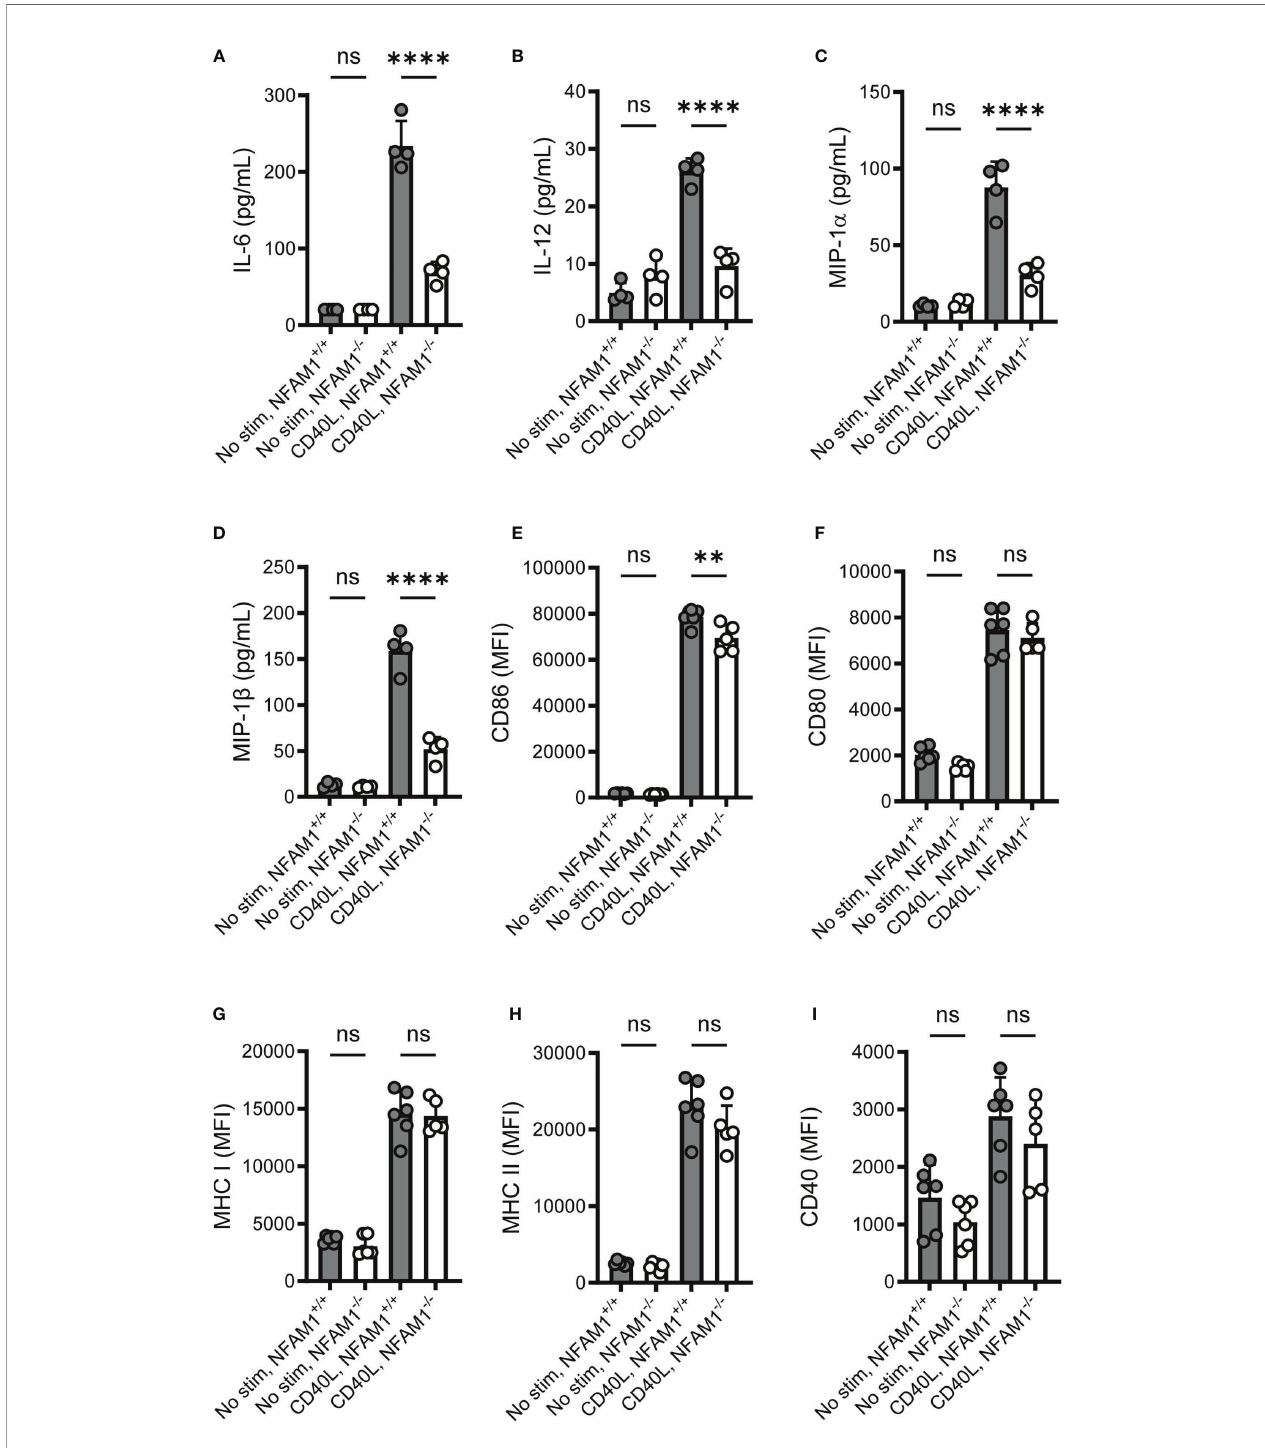
FIGURE 5 | Upon stimulation with CD40L, NFAM1 -/- monocytes exhibit reduced production of multiple pro-in fl ammatory cytokines and chemokines but have little to no defect in upregulation of cell surface activation markers. (A – D) Monocytes from 4 NFAM1 +/+ and 4 NFAM1 -/- mice were primed with IFN- g and stimulated with CD40L for 48 hours. Mean levels of IL-6, IL-12, MIP-1 a and MIP-1 b is shown in (A – D) , respectively. (E – I) . Monocytes from 6 NFAM1 +/+ and 6 NFAM1 -/- mice were primed with IFN- g and stimulated with CD40L for 24 hours. Mean expression of CD86, CD80, MHC-I, MHC-II and CD40 is shown in (E – I) respectively. Cytokine and chemokine data are representative of three independent experiments. Cell surface expression data are representative of two independent experiments. Statistical signi fi cance is depicted as follows: **** indicates a P value of <0.0001, ** indicates a P value of <0.01, and ns indicates the comparison is not statistically signi fi